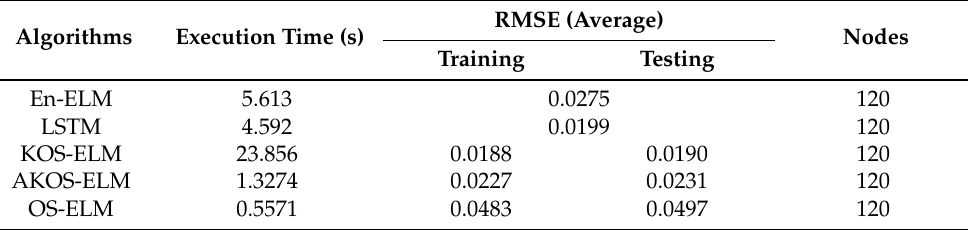
Figure 6. Prediction performance comparison of KOS-ELM, AKOS-ELM, OS-ELM, En-ELM and LSTM using a Level-5 data set (part b). Table 3. Performance comparison of KOS-ELM, AKOS-ELM, OS-ELM, En-ELM and LSTM on Level-5 sea